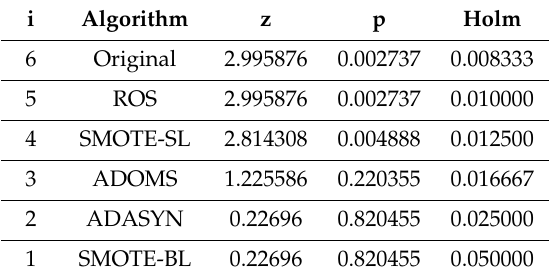
Table 25. Results of the Holm test comparing the performance of the SNDAM classifier after oversampling algorithms. The test rejects the hypothesis having an unadjusted p -value ≤